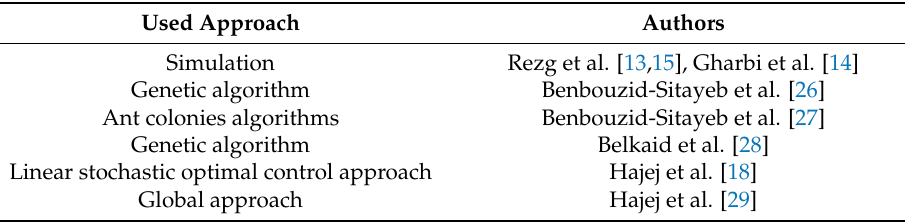
Table 1. Approaches used in solving the integrated maintenance–production